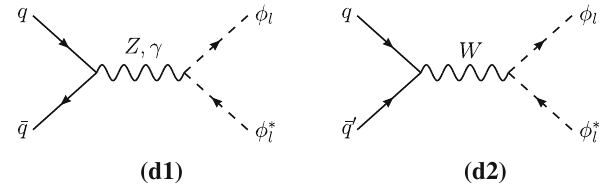
Fig. 5 Diagramsforthepairproductionoftheleptonicscalarmediator, φ μμ/μν + E / signatures in the final l , leading to T